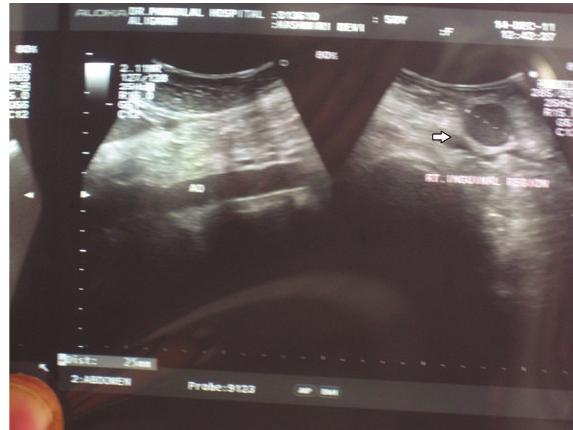
Figure 2: Ultrasound of enlarged right inguinal lymph node, 2 . 5 × 2cm.